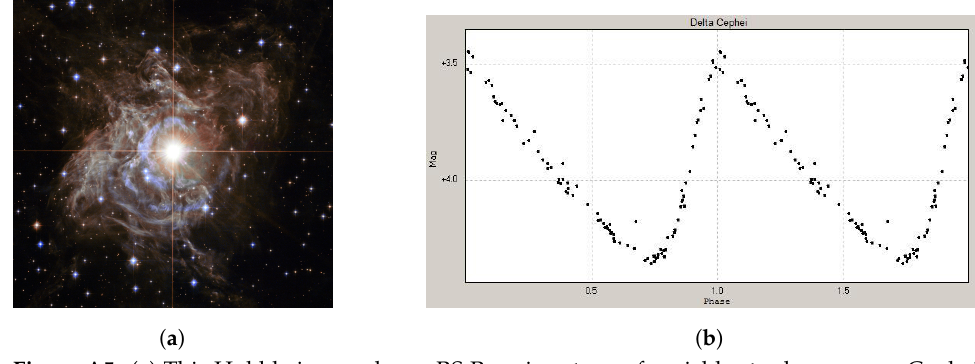
Figure A5. ( a ) This Hubble image shows RS Puppis, a type of variable star known as a Cepheid variable. Adapted from: [100]. ( b ) Phase lightcurve of variable star Delta Cepheid. Adapted from: